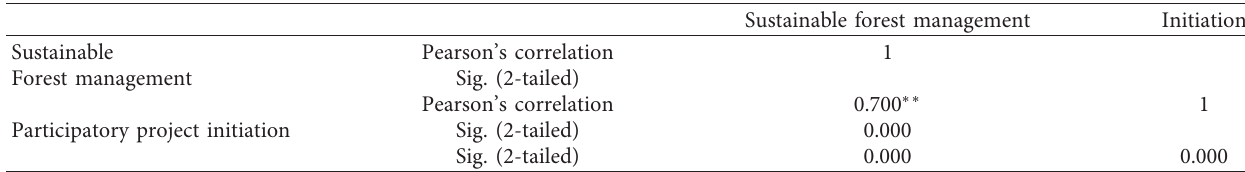
Table 3: Pearson’s correlation